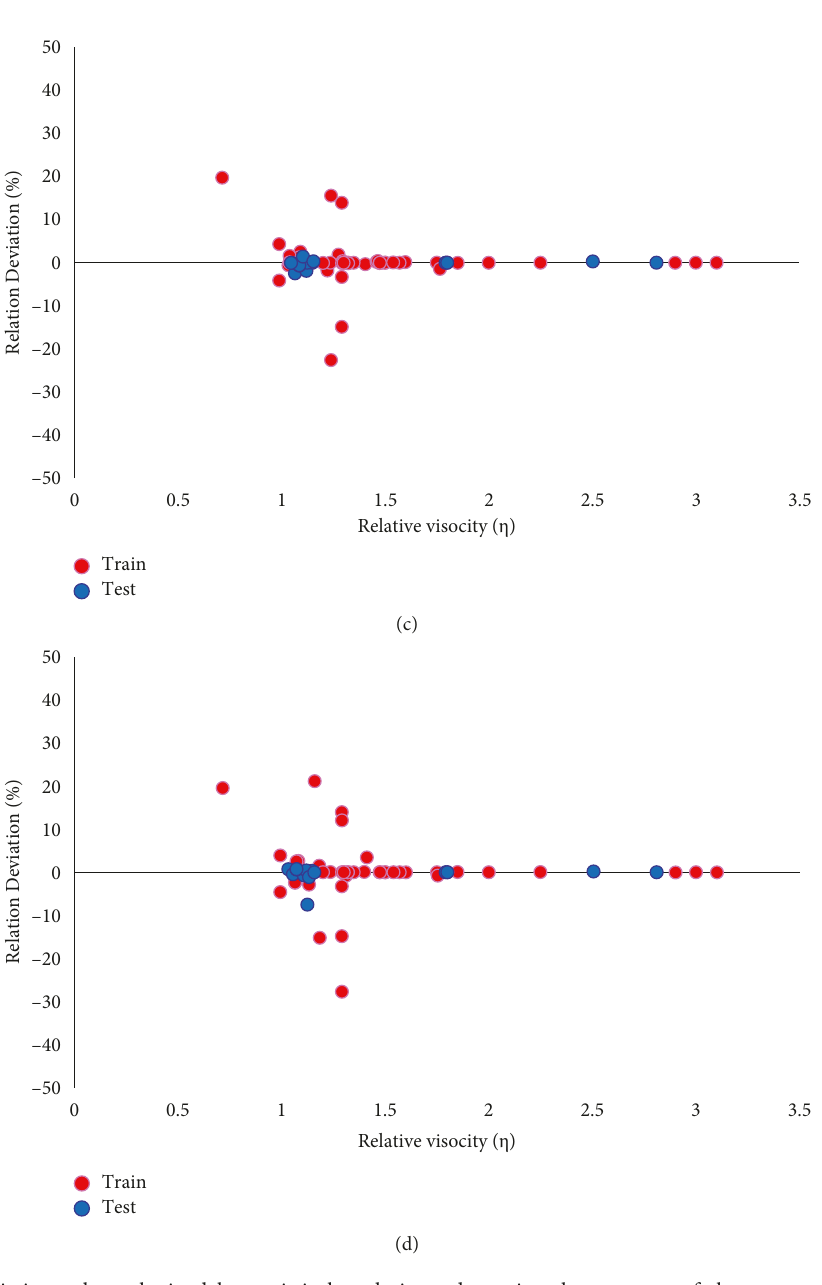
Figure 3: Relative deviation values obtained by statistical analysis to determine the accuracy of the proposed models: (a) Matern, (b) exponential, (c) squared exponential, and (d) rational